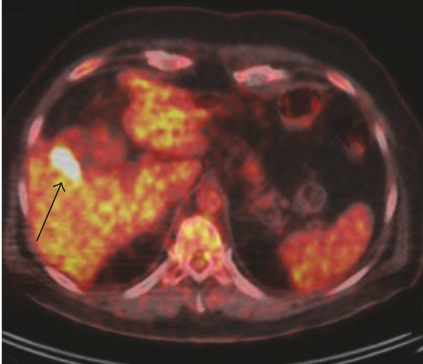
Figure 2: Fused PET/CT axial image demonstrating intense increased activity in the gallbladder (black arrow).